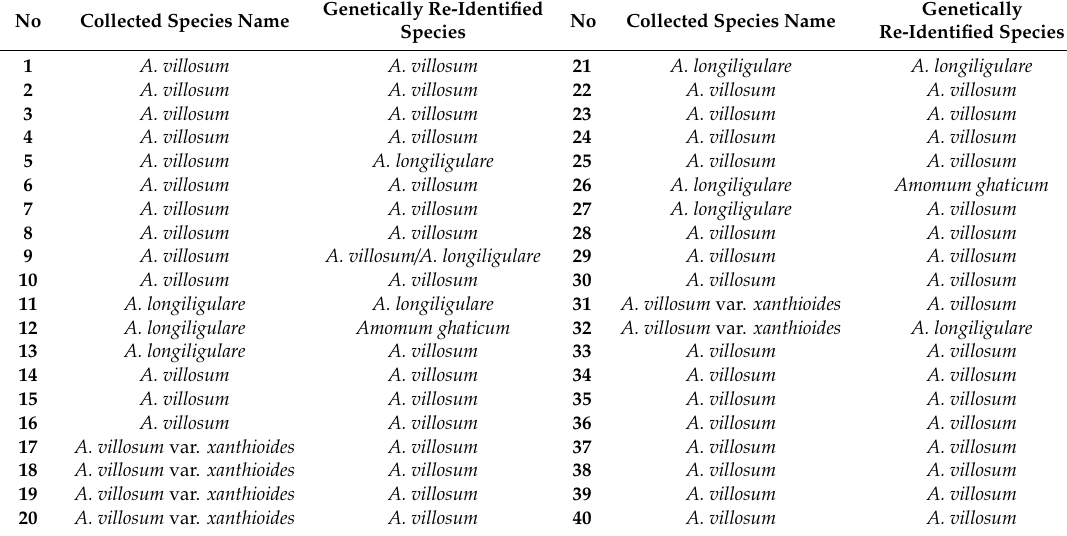
Table 3. The re-identification results of collected monitoring samples based on ITS nucleotide sequence